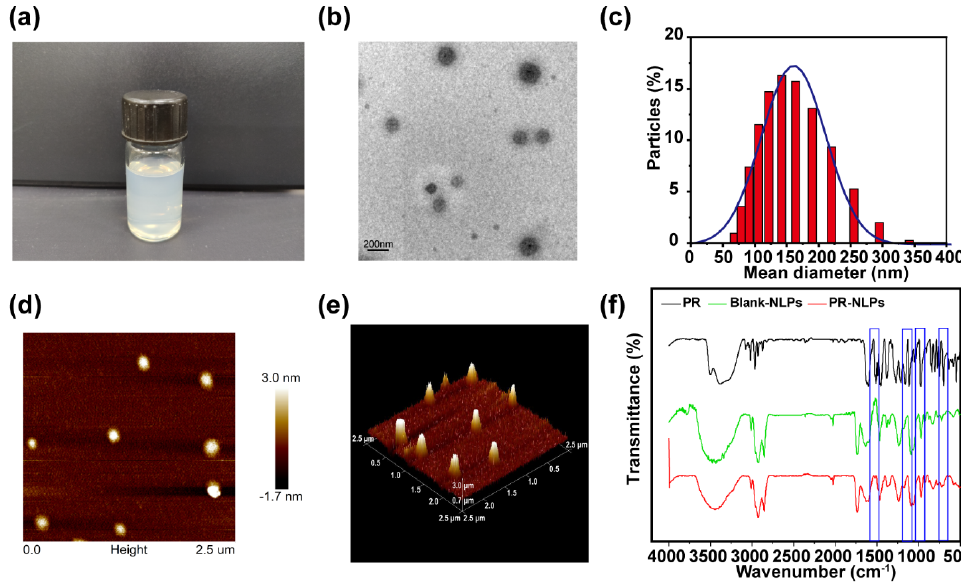
Figure 5. Characterization of PR-NLPs. ( a ) The physical appearance of PR-NLPs. ( b ) Transmission electron microscopy (TEM) measurement of PR-NLPs. ( c ) Hydrodynamic diameter (Dh) of PR- NLPs dispersion. ( d ) 2-D atomic force microscopy (AFM) image of PR-NLPs showing deformation. ( e ) 3-D atomic force microscopy (AFM) image of PR-NLPs showing height. ( f ) FTIR spectra of PR, Blank-NLPs, and PR-NLPs.